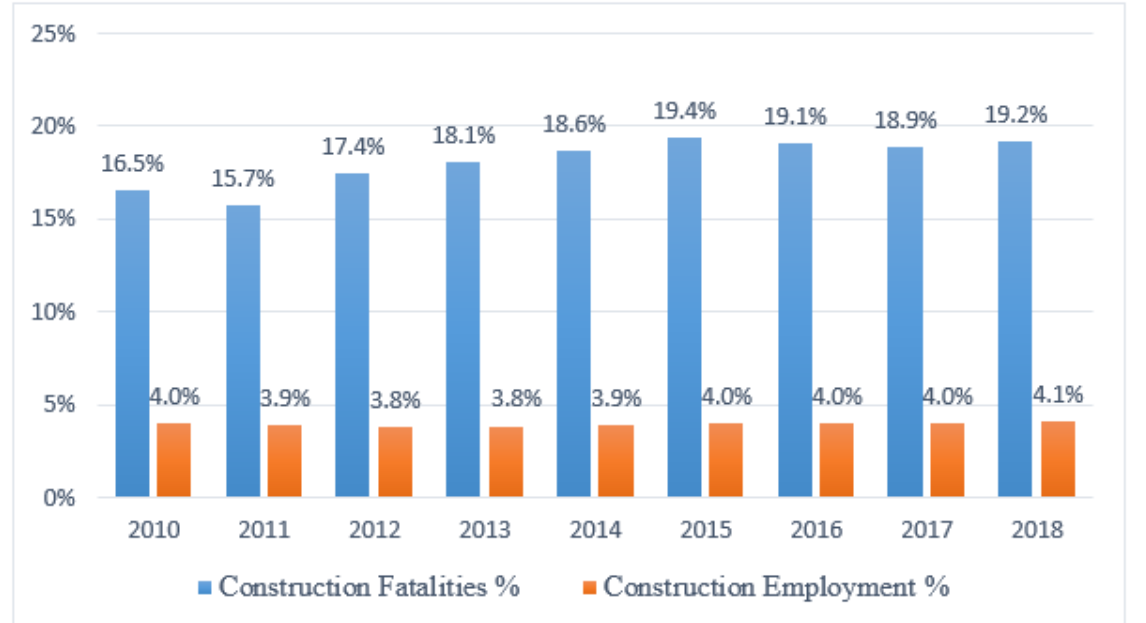
Figure 1. The share of construction fatalities and employment .